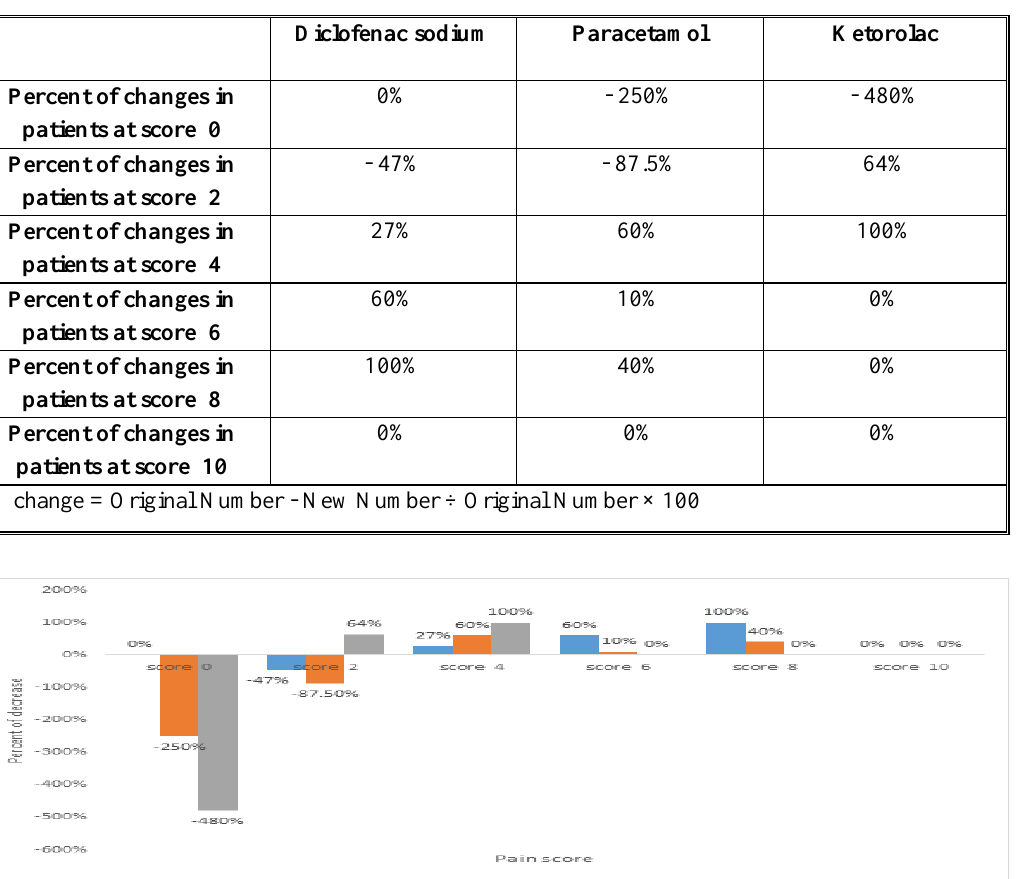
Table 4. Percent of changes in1pain1score between1301minutes and1601minutes1for the study group.